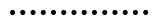
Mean spectrum of the modeled hallucinogens (___), of the modeled stimulants (_ _ _ _), and of the modeled nonamphetamines (
), from 605 to 3745 cm−1.